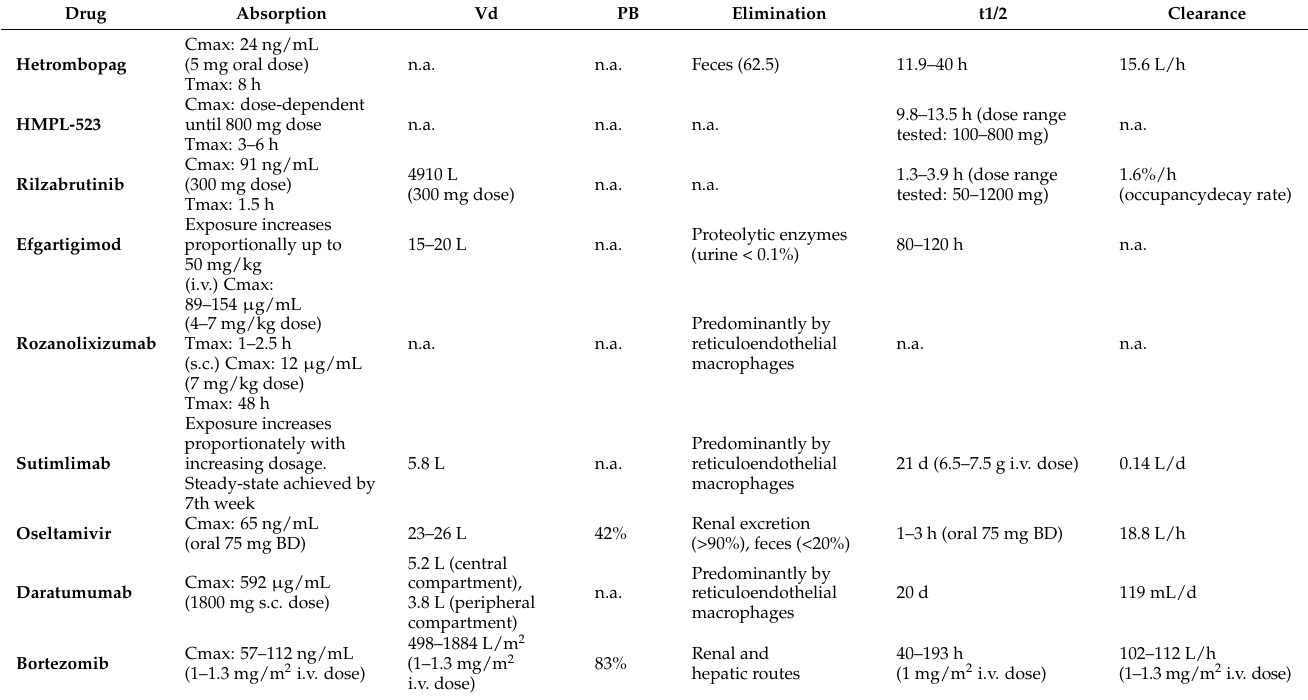
Table 6. Pharmacokinetics of drugs under clinical investigation to treat ITP patients.